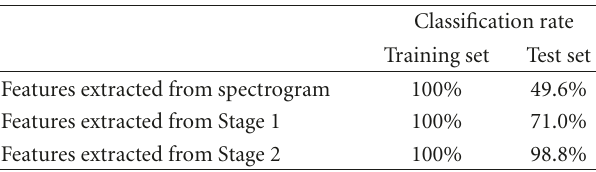
Table 1: Classification accuracy of a linear classifier using as input the features extracted at di ff erent stages.